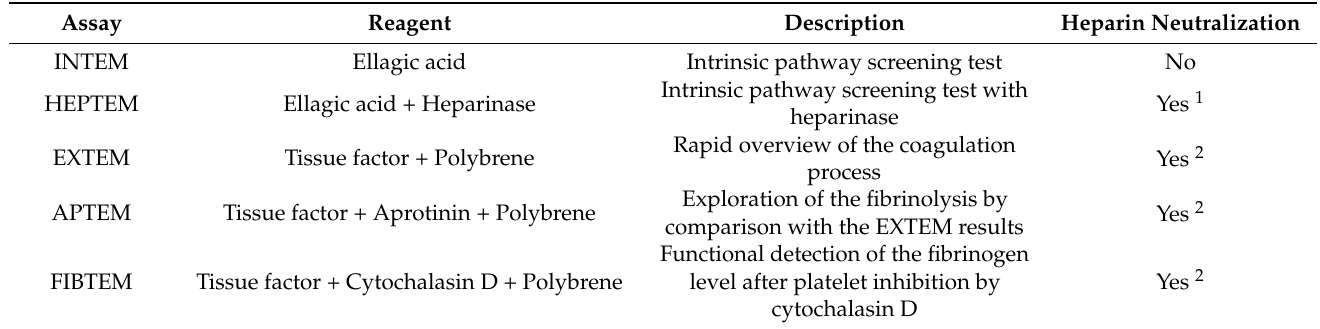
Table A1. ROTEM®reagents.